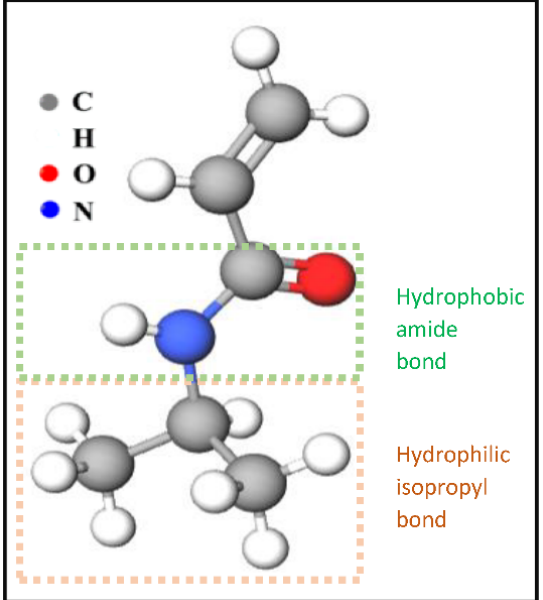
Figure 3. The chemical structure of NIPAAm monomers.